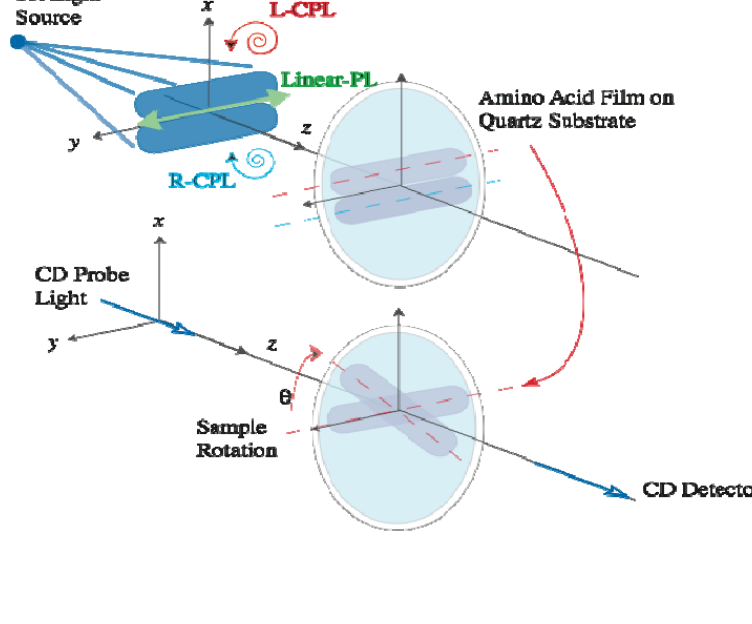
Figure 1. Schematic view of the optical arrangement of the light sources and sample for LPL and CPL irradiation and for CD